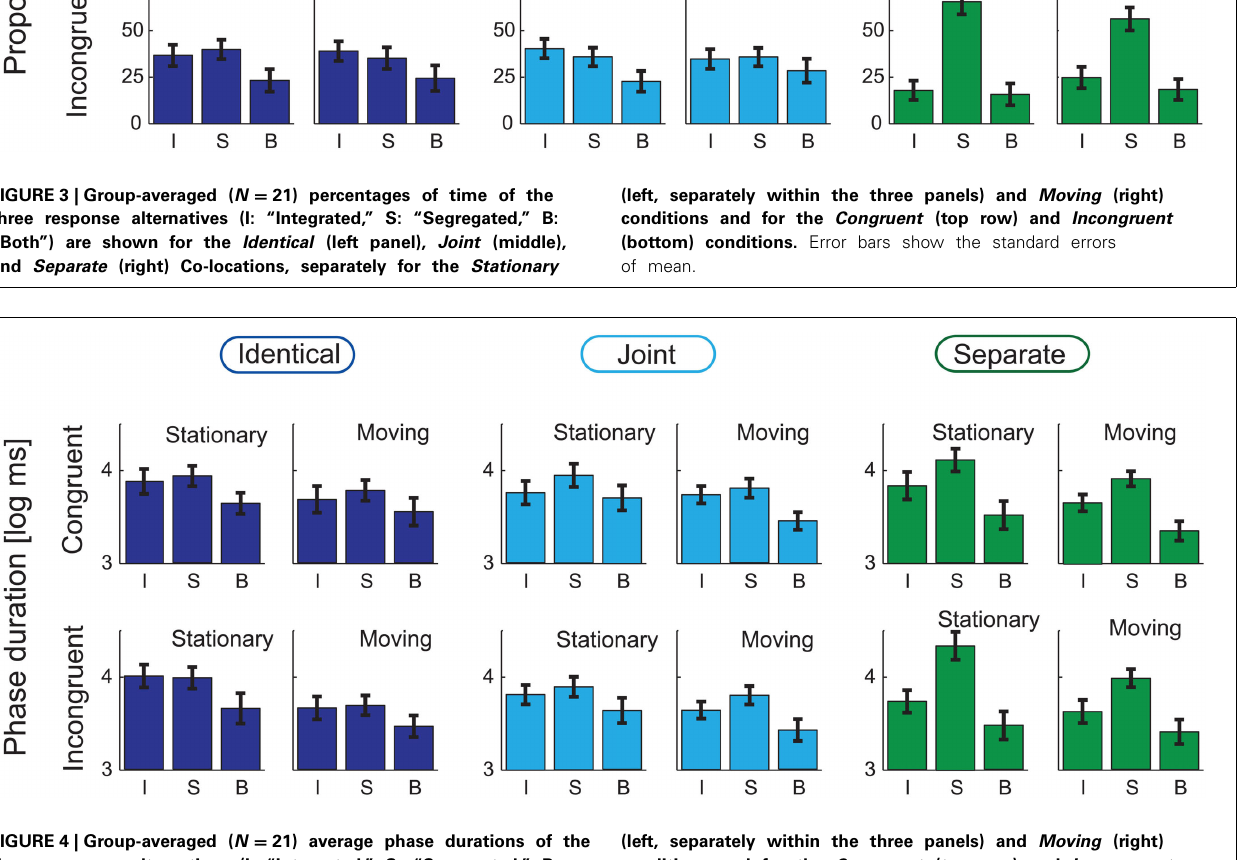
(left, separately within the three panels) and Moving (right) conditions and for the Congruent (top row) and Incongruent (bottom) conditions. Error bars show the standard errors of